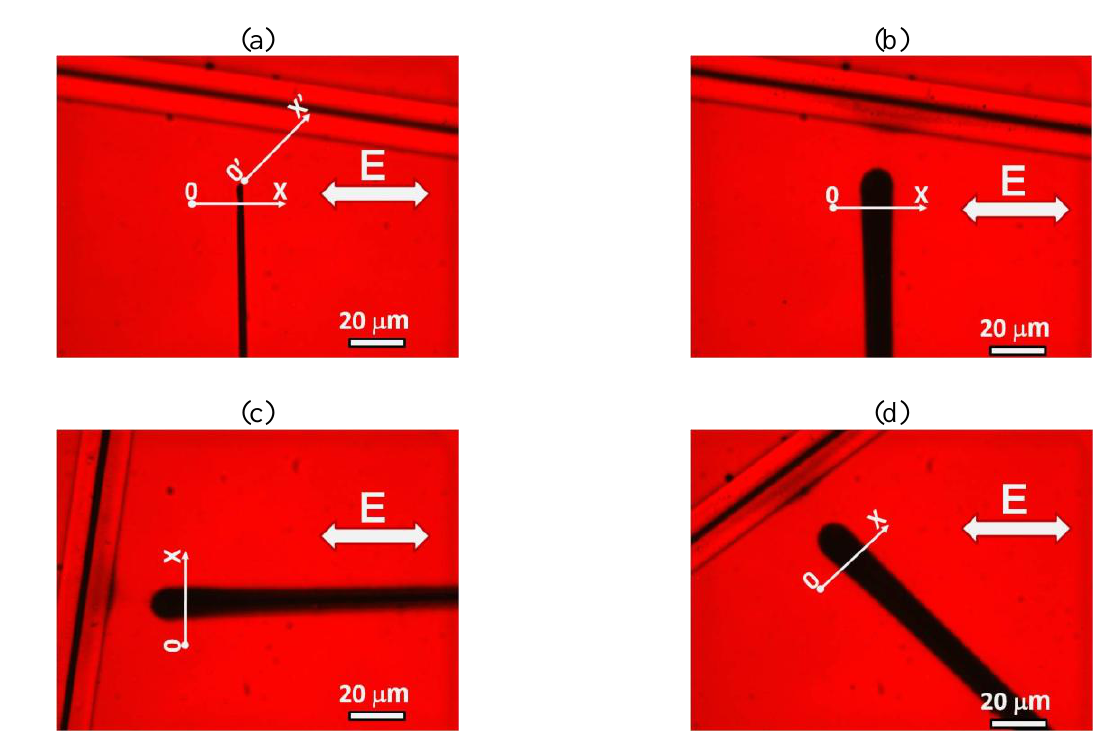
Figure 8. Polarizing microscope textures of a flat cell viewed in monochromatic light 656 nm between two parallel polarizers, at zero voltage (a) , at U = 200 V (b) , (c) , and (d) . The vector E shows the transmission direction of polarizers.